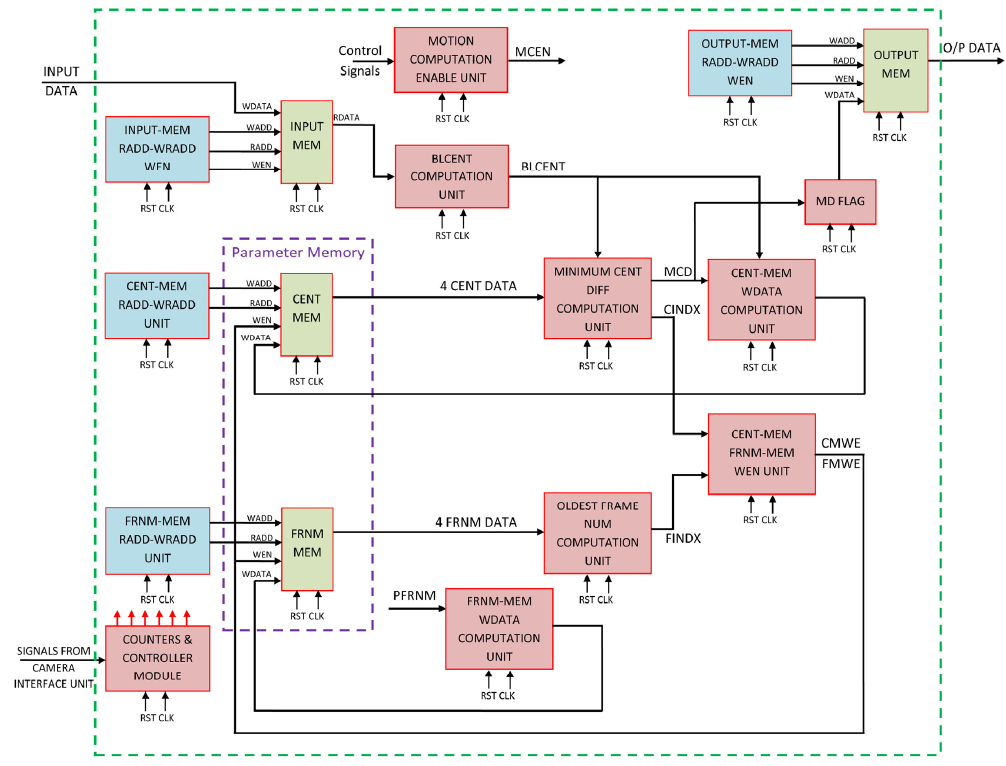
Figure 4. Proposed & Implemented VLSI Architecture for Clustering-based Motion Detection Scheme.